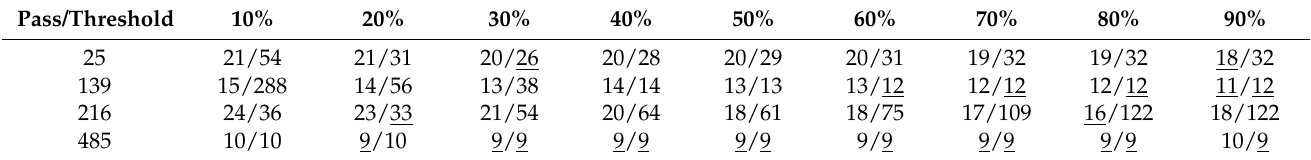
Table 4. RMSEs (cm) of the water level from retracking the first sub-waveform and the